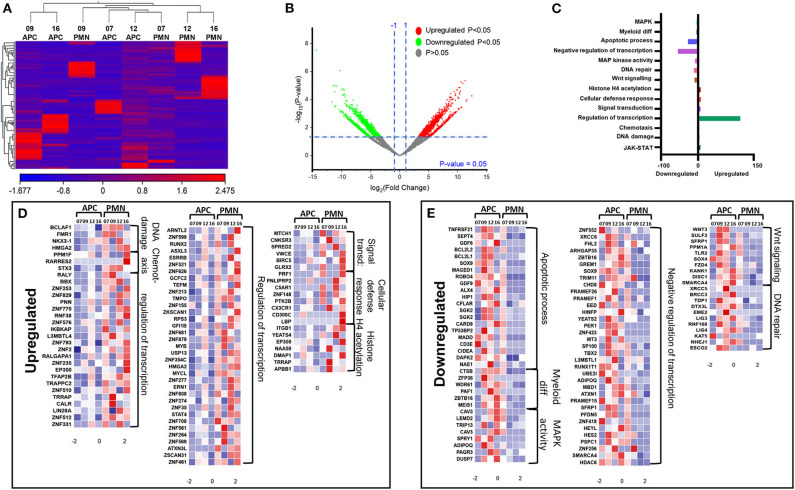
Comparative analyses of gene expression between PMN-MDSCs and monocytic APCs in the circulation of CRC patients. Hierarchical clustering of PMN-MDSCs and monocytic APCs from four patients (7, 9, 12, and 16) on differentially expressed RNA transcripts from RNA-Seq data. Each column represents a sample, and each row represents a transcript. The color gradient determines the expression level of each transcript (A). Volcano plot shows differentially expressed genes; log2 fold change is plotted on the x-axis, and the statistical impact is shown on the y-axis. Fold changes with significant P values (>0.05) are highlighted in red (for upregulated genes) and green (for downregulated genes) (B). Functional categorizations of significantly upregulated or downregulated genes were analyzed using DAVID platform. Bar diagram illustrates the percentage of genes in each functional category (C). Heat maps show the Z score of upregulated (D) and downregulated (E) transcripts in PMN-MDSCs, compared with monocytic APCs. Color codes are shown; red indicates upregulation, white indicates no change, and blue indicates downregulation.